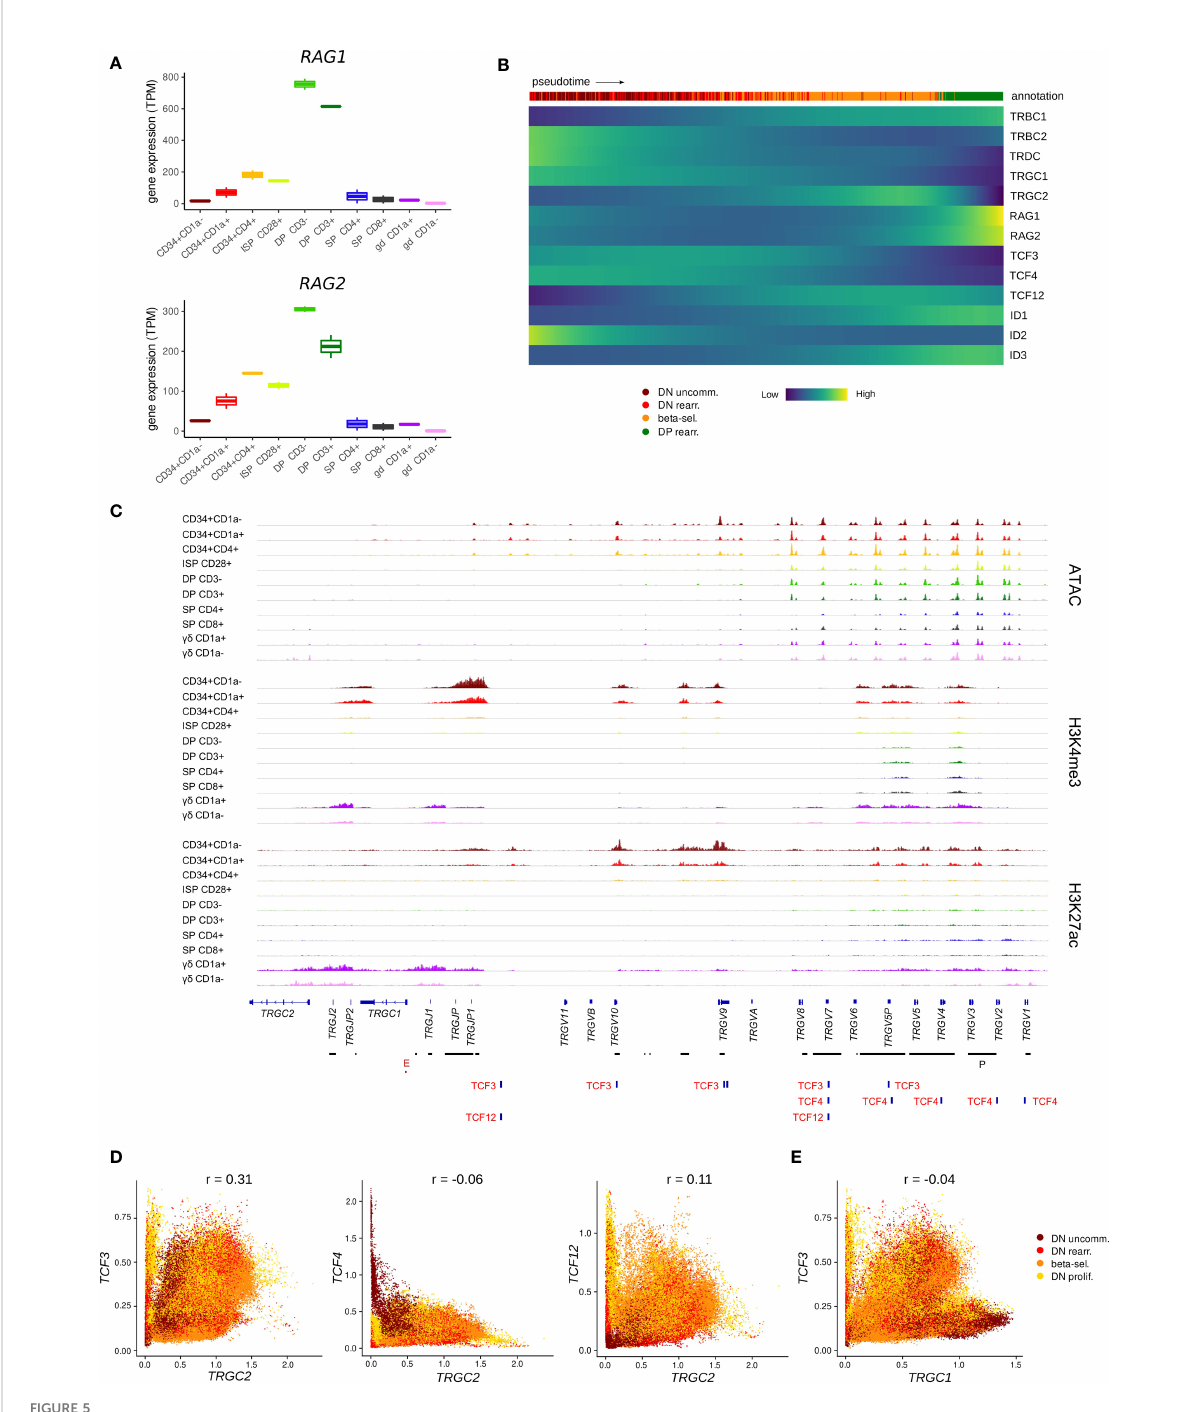
FIGURE 5 TCF3 expression is positively correlated with transcription of TRGC2 . (A) Expression of RAG1 and RAG2 at different stages of thymocyte development according to bulk RNA-seq data. (B) Heatmap showing gene expression along differentiation pseudotime in immature thymocytes. Smoothed gene expression was determined based on a generalized additive model fi tted on the cell pseudotimes, cells in pseudotime window of interest were selected and expression was scaled by gene prior to visualization. (C) Genome browser view of ATAC, H3K4me3, H3K27ac and E protein motifs at the TCRG locus. Locations of promoters (P) and enhancers (E) were retrieved from the Ensembl Regulatory Build and are indicated below the gene structure. (D) Scatter plot for imputed transcript levels of E protein encoding genes and TRGC2 in immature thymocytes. Cells are colored by cluster and Pearson correlation coef fi cient is shown. (E) Scatter plot for imputed transcript levels of TCF3 and TRGC1 in immature thymocytes. Cells are colored by cluster and Pearson correlation coef fi cient is